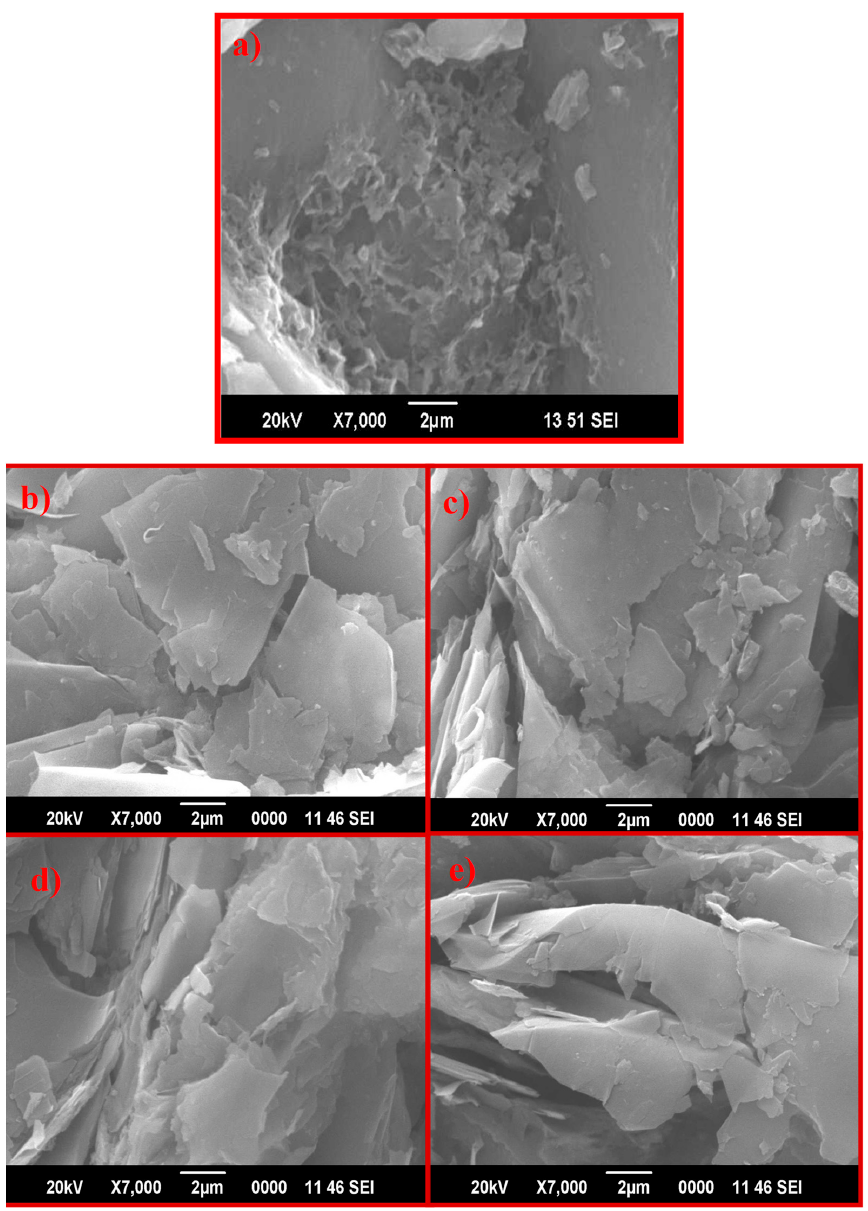
Figure 3. SEM images of graphite ( a ) K–GO ( b ), N–GO ( c ), F–GO ( d ), and C–GO ( e ).